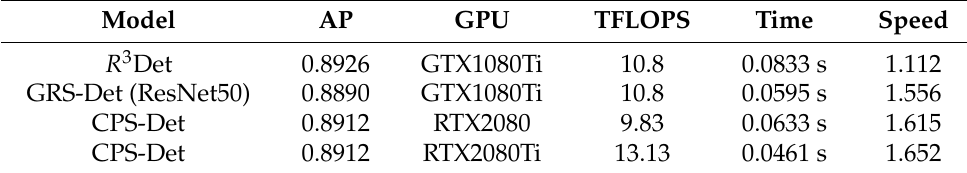
Table 5. Average speed evaluation on different